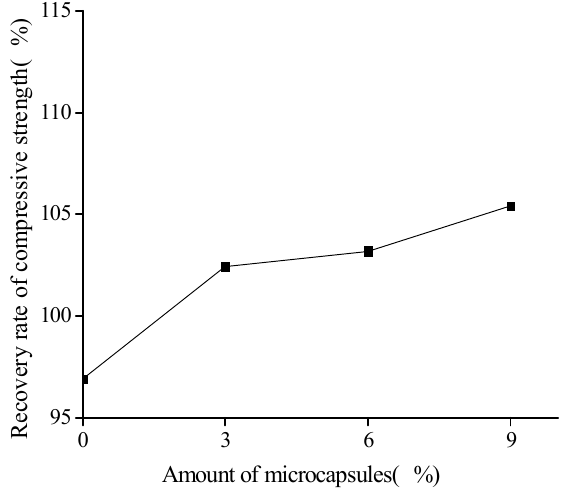
Figure 5. Healing rate (Equation (4)) of compressive strength with amount of microcapsules.